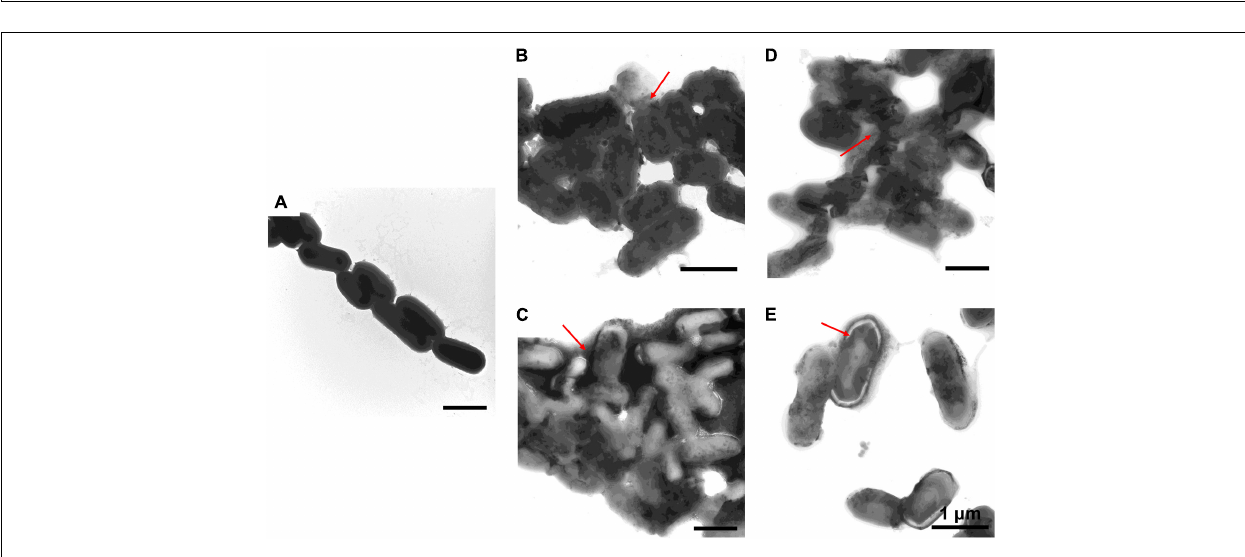
differences were considered statistically significant at values of p <